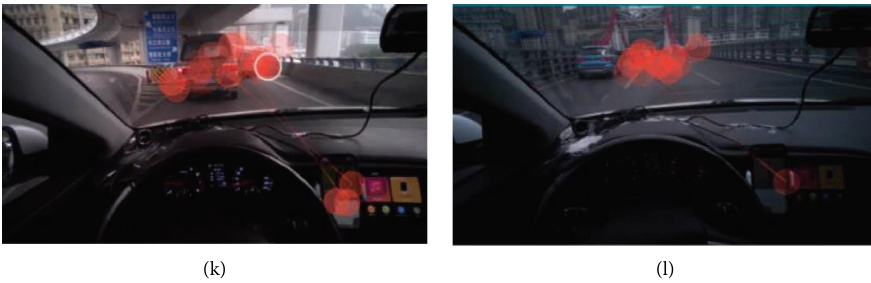
Figure 10: Gaze regions at diferent positions during the day. (a) T1-1 (0m), (b) T2-1 (2900 m), (c) T3-1 (5600m), (d) T1-2 (400 m), (e) T2-2 (4700 m), (f) T3-2 (6000m), (g) T1-3 (1200m), (h) T2-3 (5050 m), (i) T3-3 (8700 m), (j) B1-3 (1900m), (k) R-2 (2600 m), and (l) B2-1 (5300